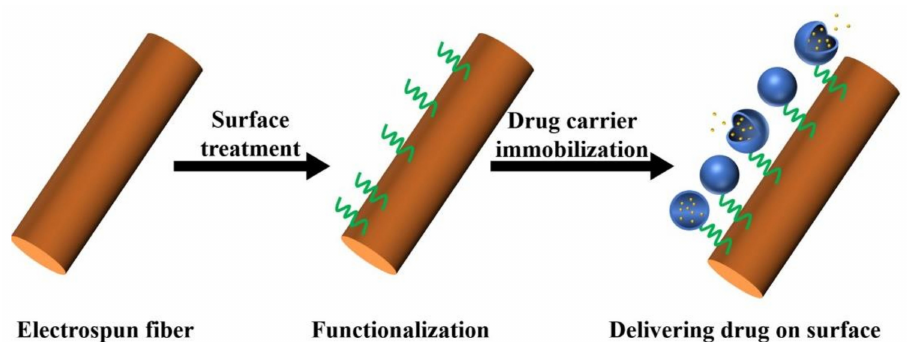
Figure 10. Electrospun fibrous drug delivery system built by immobilizing drug carriers onto the modified surface